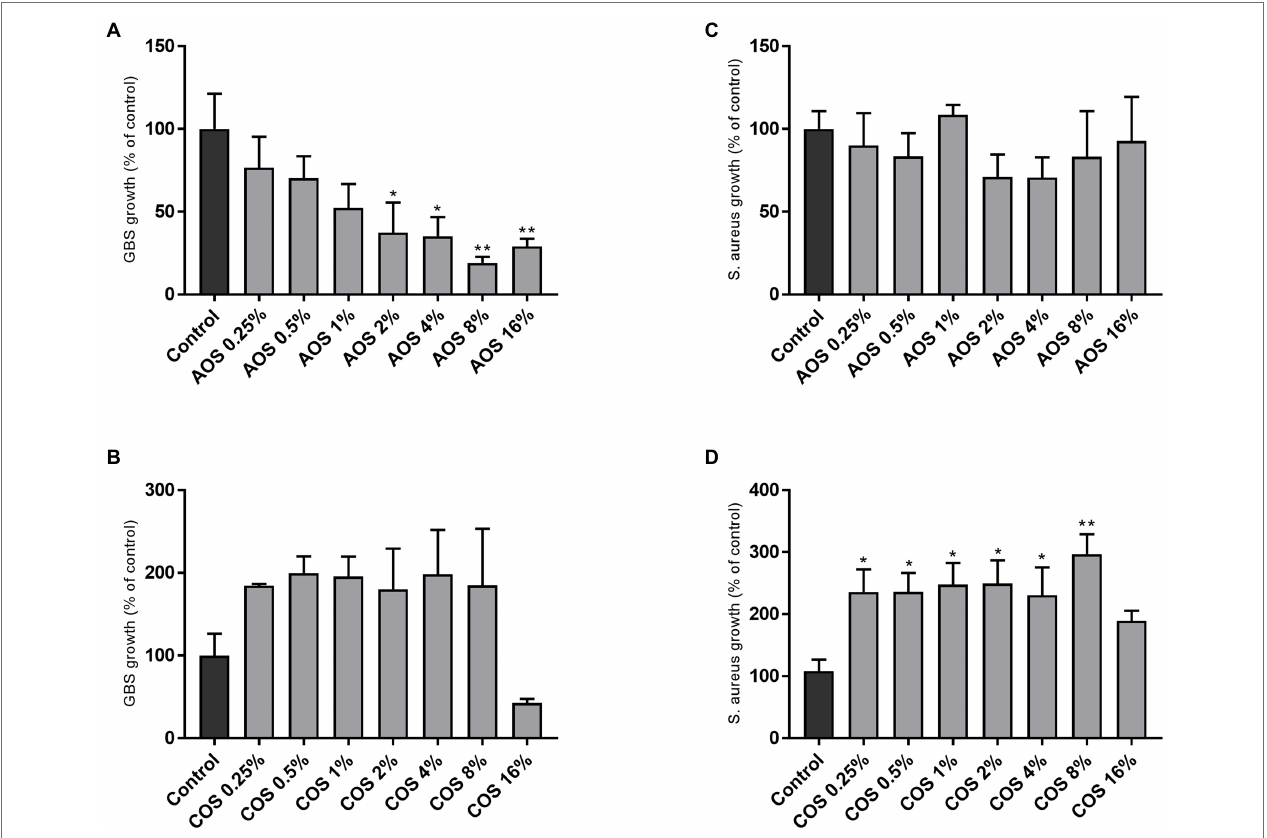
FIGURE 2 | Effect of AOS and COS on bacterial growth of GBS V and S. aureus wood 46 strains in TSB. In order to identify the MIC of AOS and COS against GBS V (A,B) and S. aureus wood 46 (C,D) , seven 2-fold serial dilutions of each NDO were examined, as described in the Material and Methods section. Control represents the percentage of the maximum growth of bacteria without any intervention. Results are expressed as the percentage of bacterial growth (relative to control) as mean ± SEM of three independent experiments each performed in triplicate. Statistical differences *( p < 0.05) and **( p < 0.01) compared to positive control were obtained using one-way ANOVA test. AOS, alginate oligosaccharides and COS, chitosan